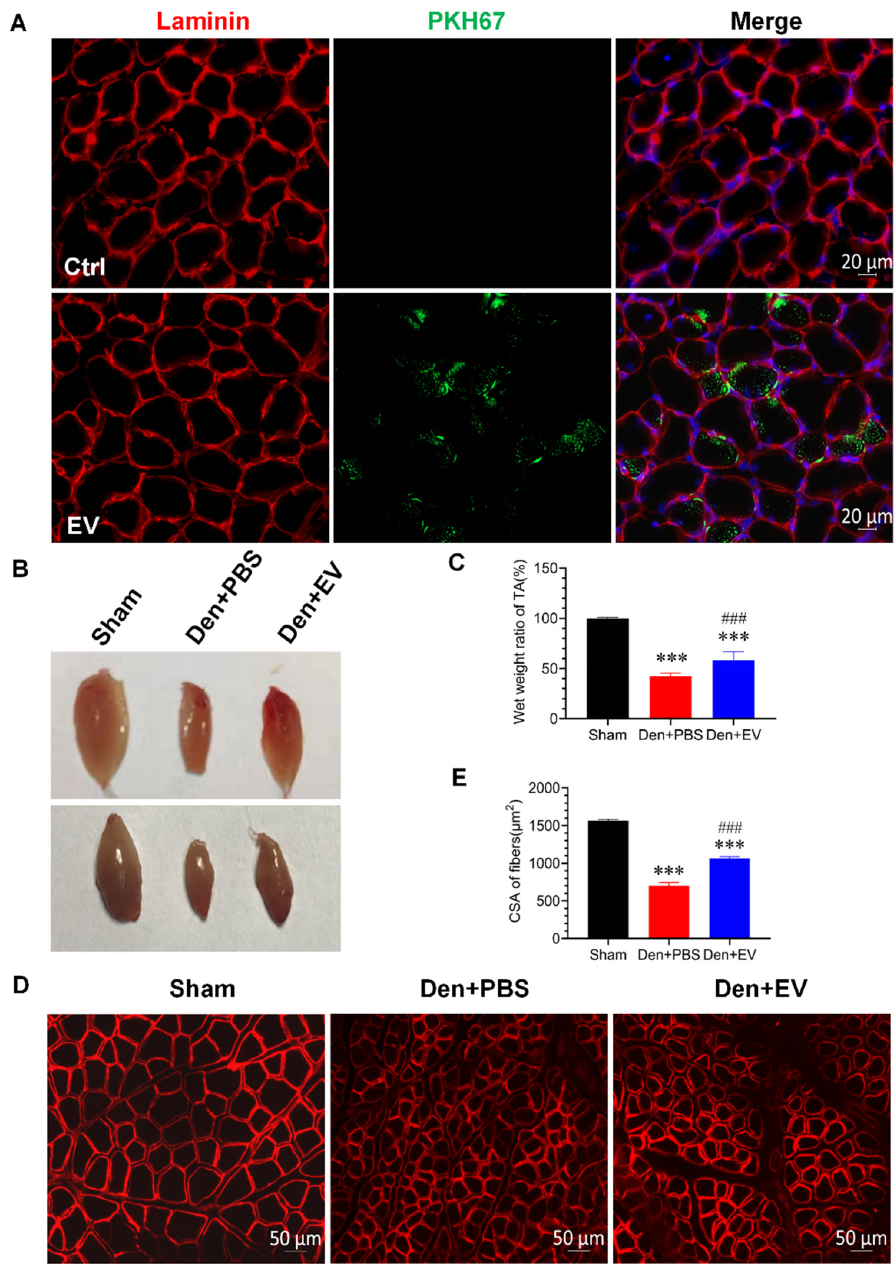
Figure 6. SKP-SC-EVs alleviate denervated skeletal muscle atrophy. ( A ) EVs labeled with PKH67 (green) are displayed in the muscle fibers (red), and the nucleus is labeled with DAPI (blue). Scale bar = 20 μ m. The tibialis anterior muscle was injected with PBS (Ctrl group) or PKH67-labeled EVs (EV group). ( B ) General observation of the effect of SKP-SC-EVs on denervated muscle atrophy. ( C ) Histogram indicating the effect of SKP-SC-EVs on the wet weight ratio after denervated muscle atrophy. n = 10, *** p < 0.001 vs. Sham group; ### p < 0.001 vs. Den + PBS group. ( D ) Laminin (red) staining of muscle fiber cross-sections in different treatment groups after denervated muscle atrophy. Scale bar = 50 μ m. ( E ) Statistical analysis of muscle fiber cross-sections. n = 5, *** p < 0.001 vs. Sham group; ### p < 0.001 vs. Den + PBS group. The sham group was injected with PBS; the Den group was injected with PBS containing SKP-SC-EVs (5 × 10 10 particles) (Den + EV group), and; the Ctrl PBS group (Den + PBS group) was injected with PBS. The tibialis anterior muscle samples were collected 14 days after treatment. Den, denervation; EVs, extracellular vesicles; SCs, Schwann cells; SKP, skin-derived precursors.